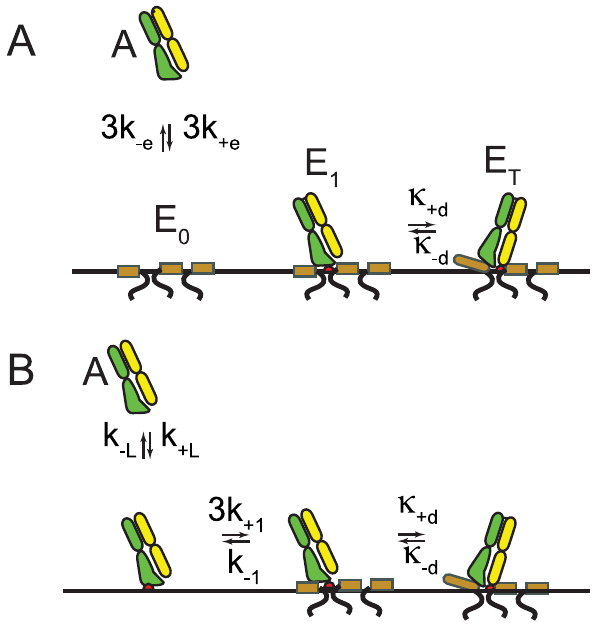
Figure 1. A. Two step binding scheme for a polyreactive Fab binding to an epitope. The epitope is exposed transiently for a mean time 1/ l before virion and target cell membranes fuse and infection becomes irreversible. Only the transmembrane domain and the MPER on the viral membrane are pictured. The remainder of gp41, which extends into the target cell membrane, is not shown. The first step, binding from solution to the MPER on the virion surface is described by rate constants k z e and k { e . The second step, an induced conforma- tional change resulting in a long-lived Fab-MPER complex, is described by intramolecular rate constants k z d and k { d . The model assumes that if an Fab remains bound to the MPER after the conformational change for a sufficient time ( 1 = d T ) the epitope is disabled. B. In the encounter model the Fab binds first to lipids on the membrane with rate constants k z L and k { L , then diffuses to the MPER and reacts with surface rate constants k z 1 and k { 1 . Because binding to the lipid is weak and rapidly reversible we show in SI1 of Text S1 that for this model k z e ~ K L Lk z 1 and k { e ~ k { 1 . Here K L ~ k z L = k { L is the lipid equilibrium constant and L is the surface concentration of lipid binding